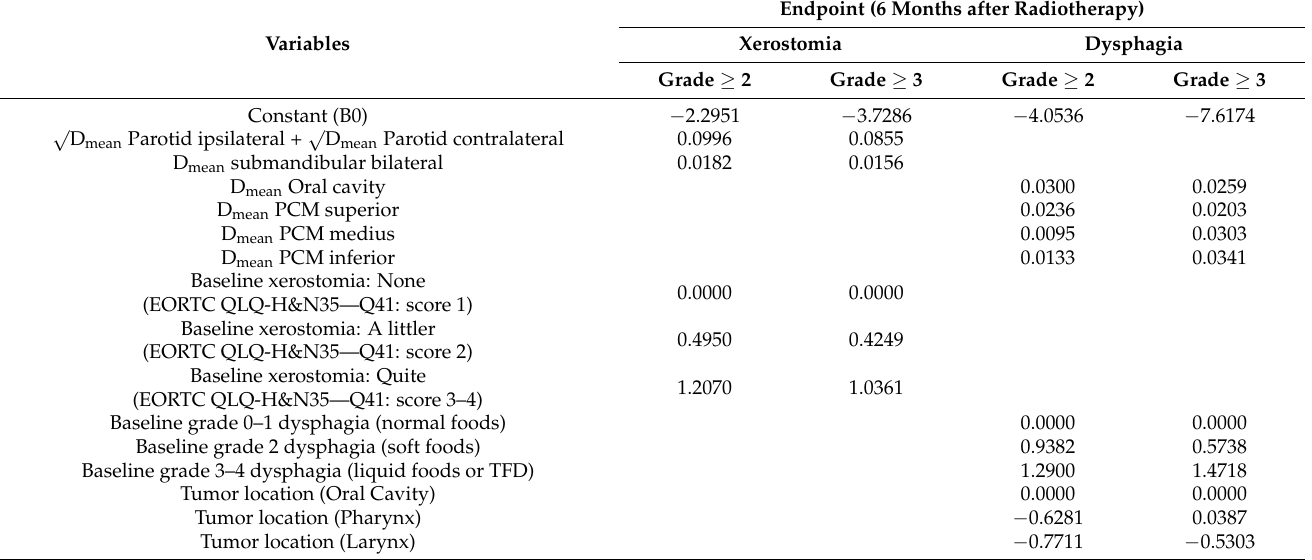
Table A1. NTCP models used for patients selection in revised Dutch National Indication Protocol for Proton Therapy.